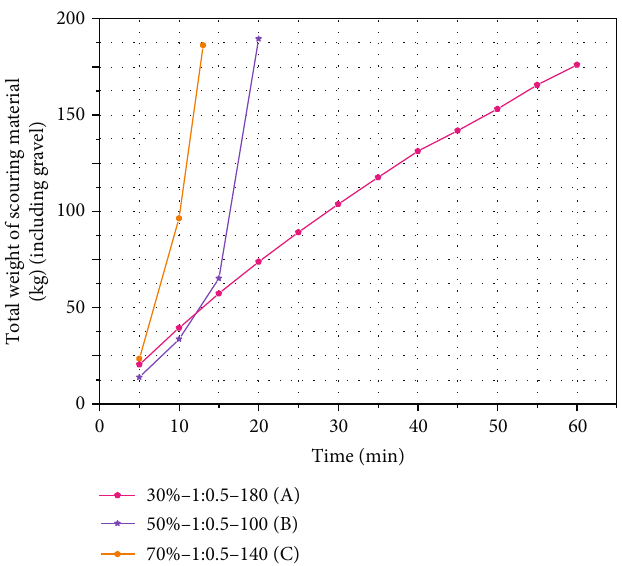
Figure 13: Time-history curve of the total mass of scoured material on steep slopes.